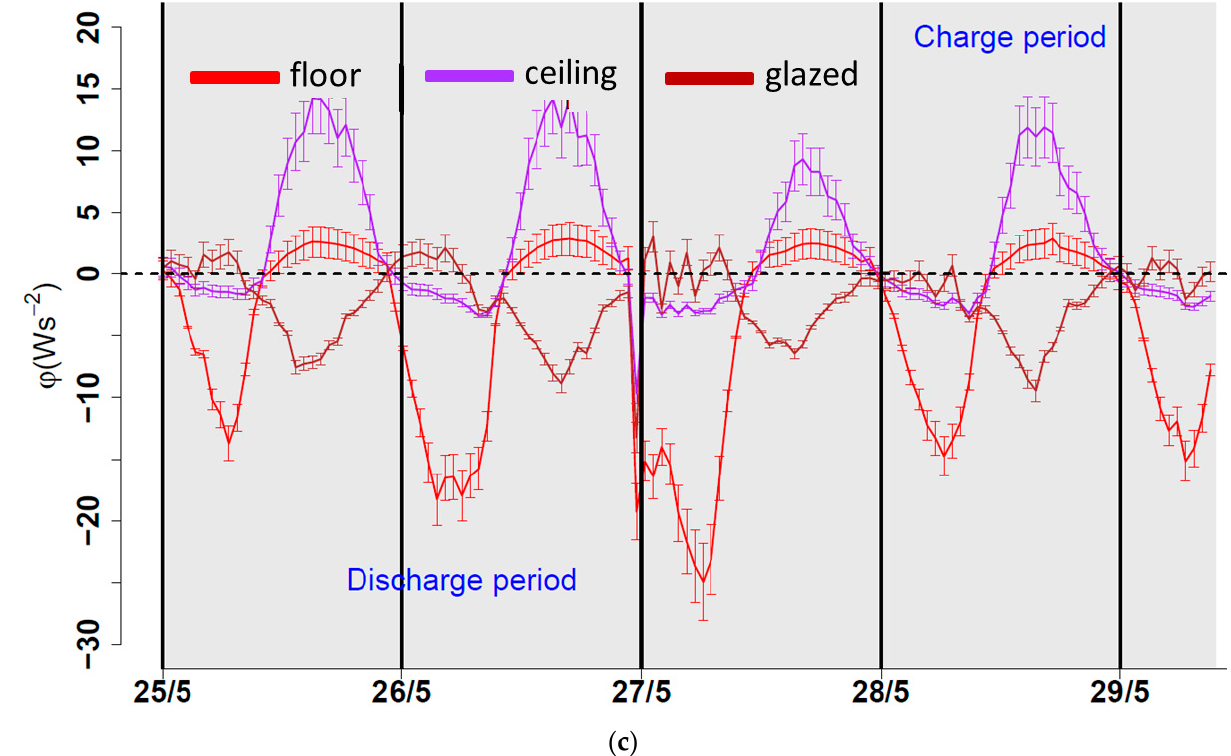
Figure 6. Convective heat flux for: ( a ) config. #1, ( b ) config. #2, and ( c ) config. #3.